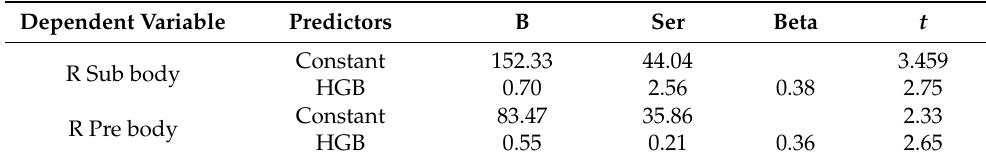
Table 3. Multiple linear regression analysis of the hippocampal subregion, amygdala subregion, and biochemical indexes within the two groups.